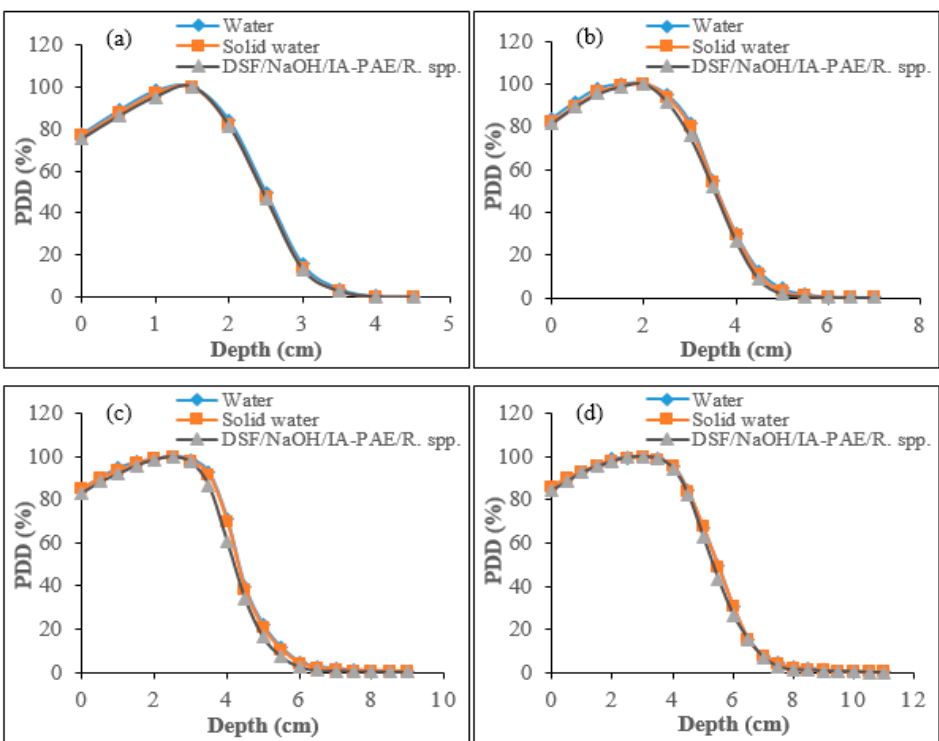
Figure 10. PDD curves for water, solid water, and DSF/NaOH/IA-PAE/ R. spp. particleboard